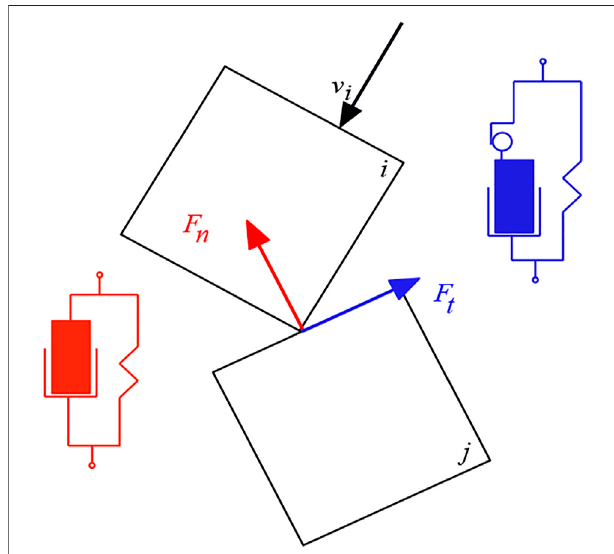
FIGURE 1 | Spring-damper contact force